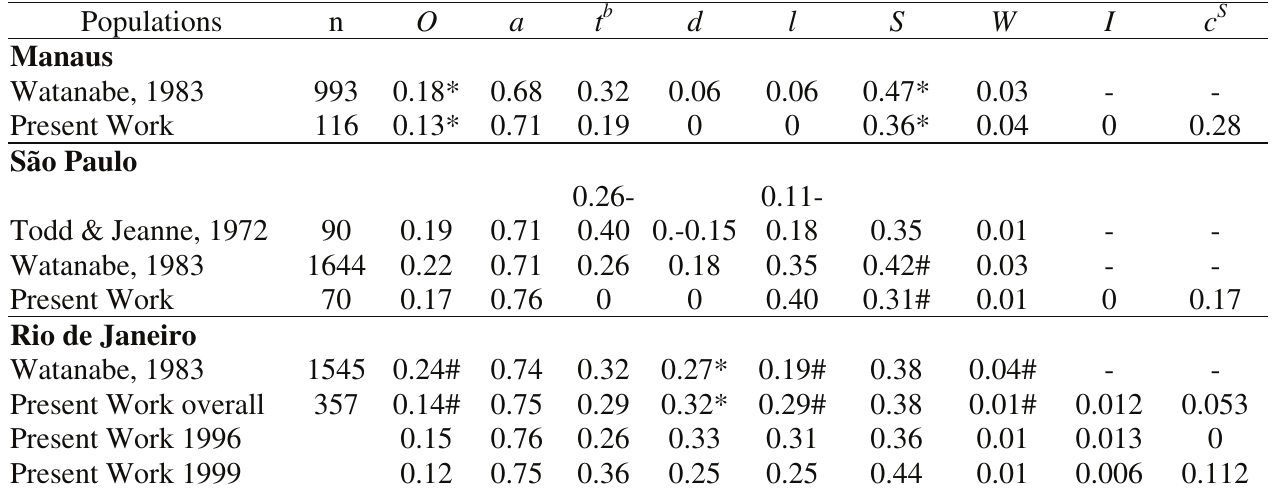
Table S4. Temporal allele frequency changes in the cat populations of Manaus, São Paulo and Rio de Janeiro (Brazil), sampled throughout time for 9 morphological loci. * = borderline significant differences; # = statistically significant differences; N = sample